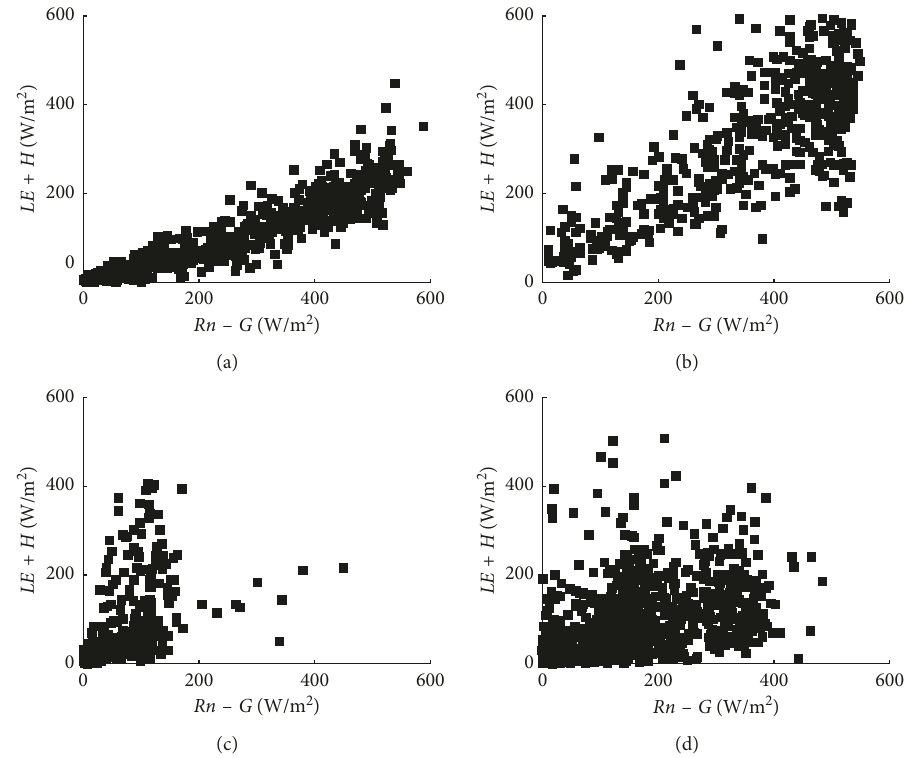
Figure 4: Energy balance closure analyses for the three campaigns. Each symbol represents a measured half-hourly data point. (a) S1: banana screenhouse; (b) S2: pepper screenhouse (above screen); (c) S2: pepper screenhouse (below screen); (d) S3: tomato